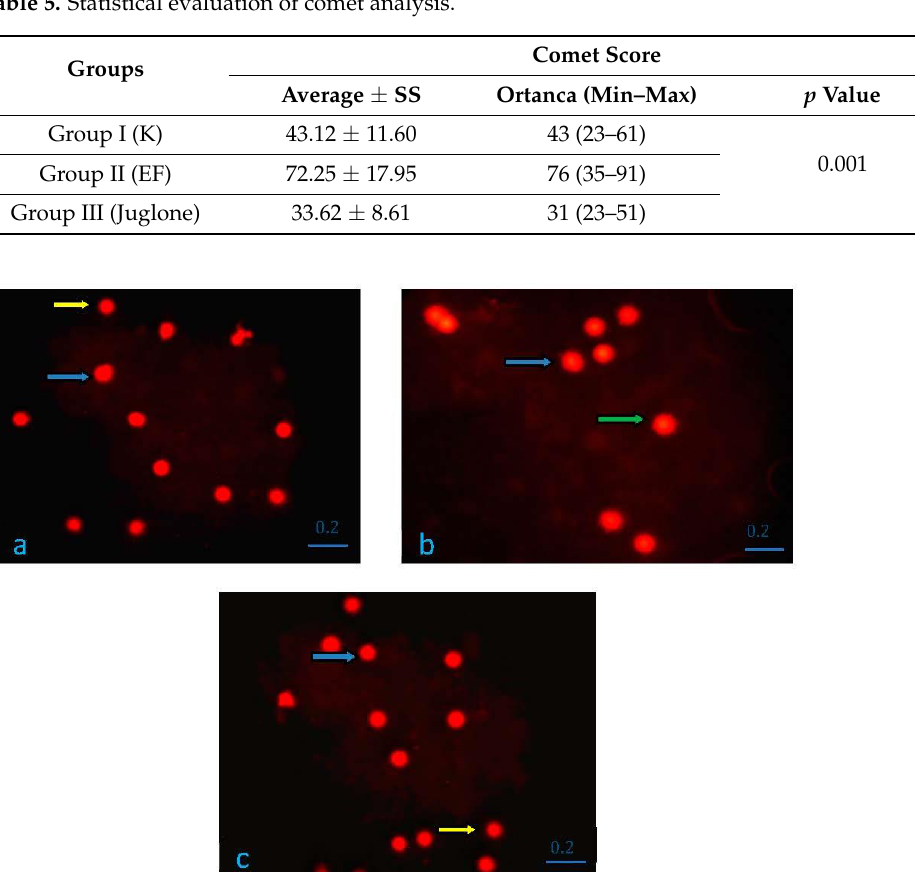
Figure 4. ( a ) Group I (K) Comet Analysis. Yellow arrow, Category 0, cell with no damage. Blue arrow, 1st category, less damaged cell; ( b ) Group II (EF) Comet Analysis. Blue arrow, Category 1, slightly damaged cell. Green arrow, Category 2, heavily damaged cell; ( c ) Group III (EF + Juglone) Comet Analysis. Yellow arrow, Category 0, cell with no damage. Blue arrow, Category 1, slightly damaged cell.